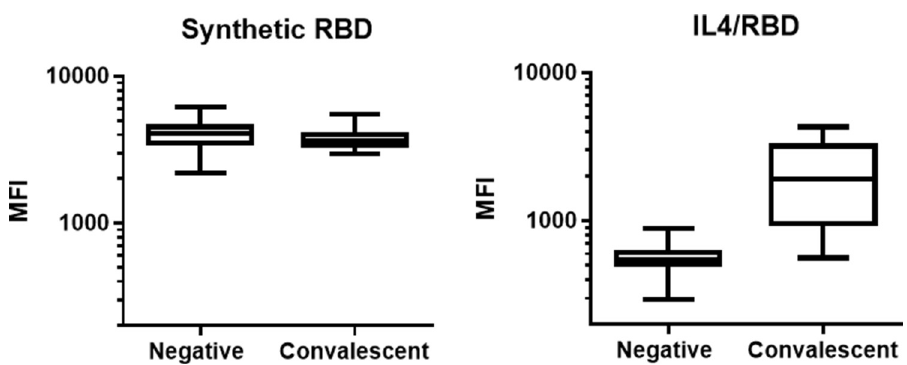
Fig 1. Comparison between fluorescent bead COVID-19 assays using synthetic RBD or mammalian expressed IL- 4/RBD fusion protein as antigens for serologic testing. Negative serum samples (n = 78) were taken in 2019 prior to the COVID-19 pandemic. Convalescent serum samples (n = 21) were obtained from COVID-19 patients (n = 11). The plots represent pan-Ig median fluorescence intensity (MFI) values.